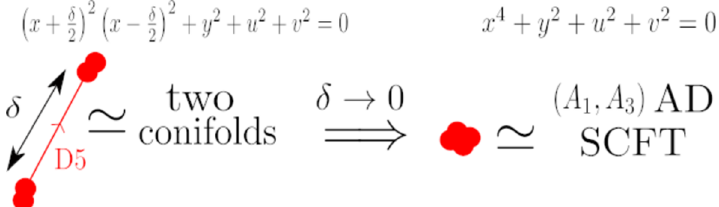
Figure 7 . Left: two pairs of two coincident defects, separated from each other a distance δ corresponds to two conifolds sharing a compact B-cycle with volume δ . Right: colliding the two pairs is dual to shrinking the conifold B-cycle and leads to the geometrically engineered ( A 1 , A 3 ) AD